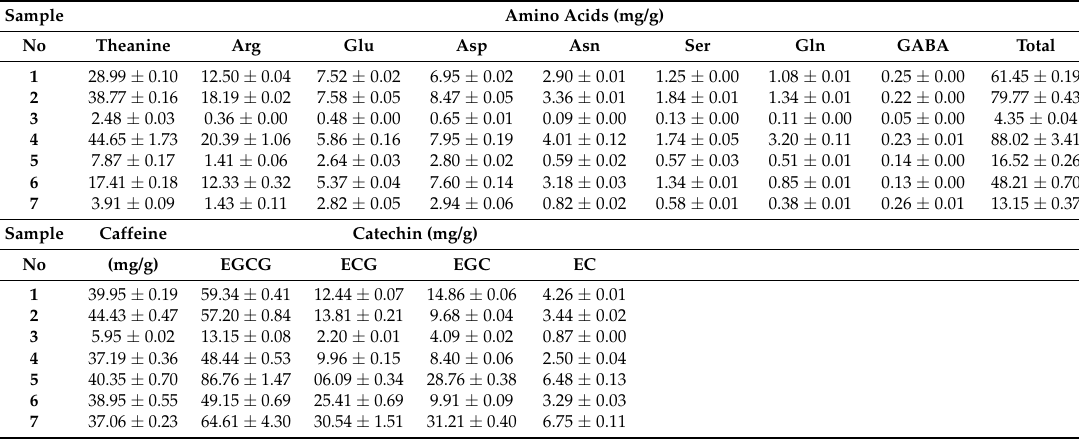
Figure 2. Correlations between adrenal hypertrophy and ingestion of matcha components in stressed mice. The amounts of ( a ) theanine and ( b ) caffeine were calculated from the matcha-containing feed that each mouse consumed, as shown in Table 3. Each point and bar shows the mean ± SEM ( n = 4–8). Table 2. Ingredient composition in each matcha sample.